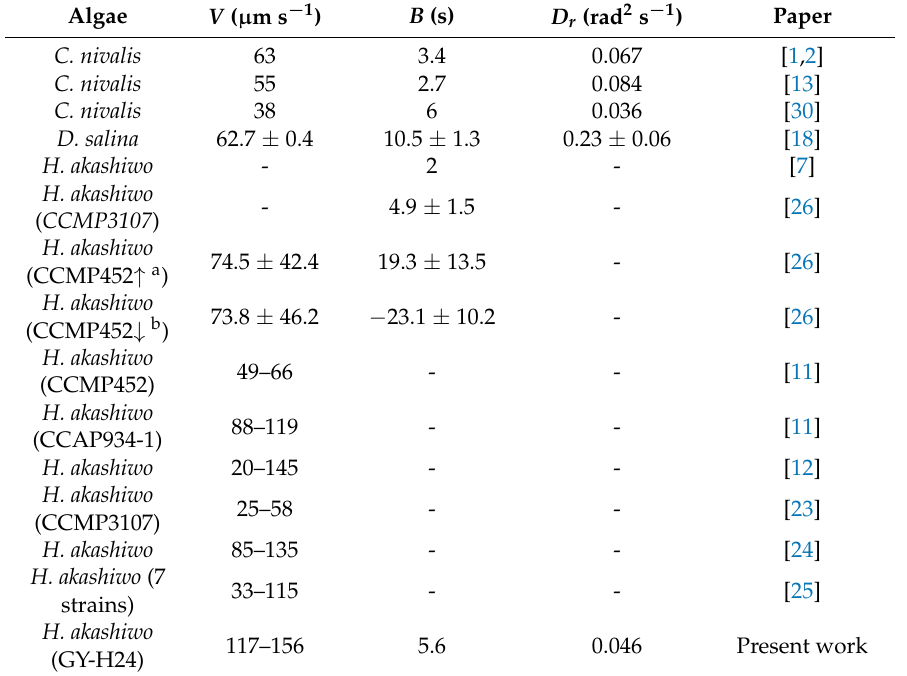
Table 2. Gyrotactic parameters of various algal